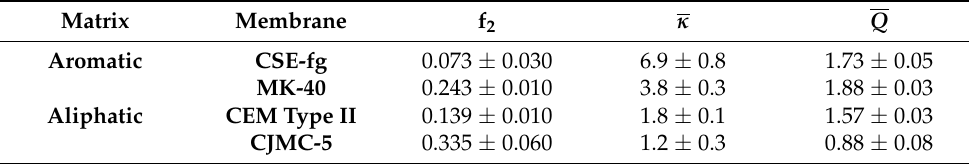
Figure 4. Concentration dependencies of ( a ) specific electric conductivity of the studied membranes, κ membrane (mS/cm), and ( b ) the same dependencies presented in logarithmic coordinates. Table 4. The volume fraction of the intergel space of membranes under study and corresponding electrical conductivity ( κ ) and ion exchange capacity ( Q ) of their gel